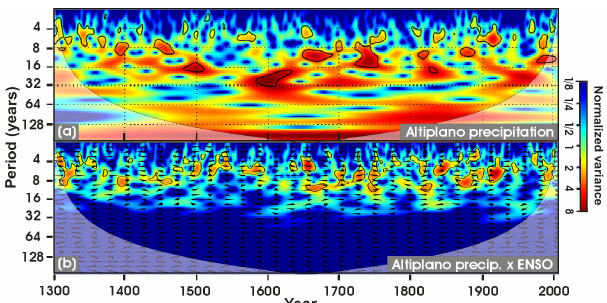
Fig. 7. The wavelet (WT) power spectrum (Morlet) of the annual (November–October) precipitation reconstruction in the Altiplano region (a) , and the cross-wavelet transform (XWT) between the precipitation reconstruction in the Altiplano and the first principal component of the North American Drought Atlas (NADA) as an ENSO proxy during the period 1300–2006 (Cook et al., 2004; Li et al., 2011) (b) . Thick black contours indicate the 95% significance based on the red noise model, and the cone of influence is shown as a lighter shade at the bottom of both figures. Vectors indicate the relative phase relationship between the Altiplano precipitation and NADA PC1. Horizontal arrows pointing right and left correspond to in-phase and antiphase relationships between records,